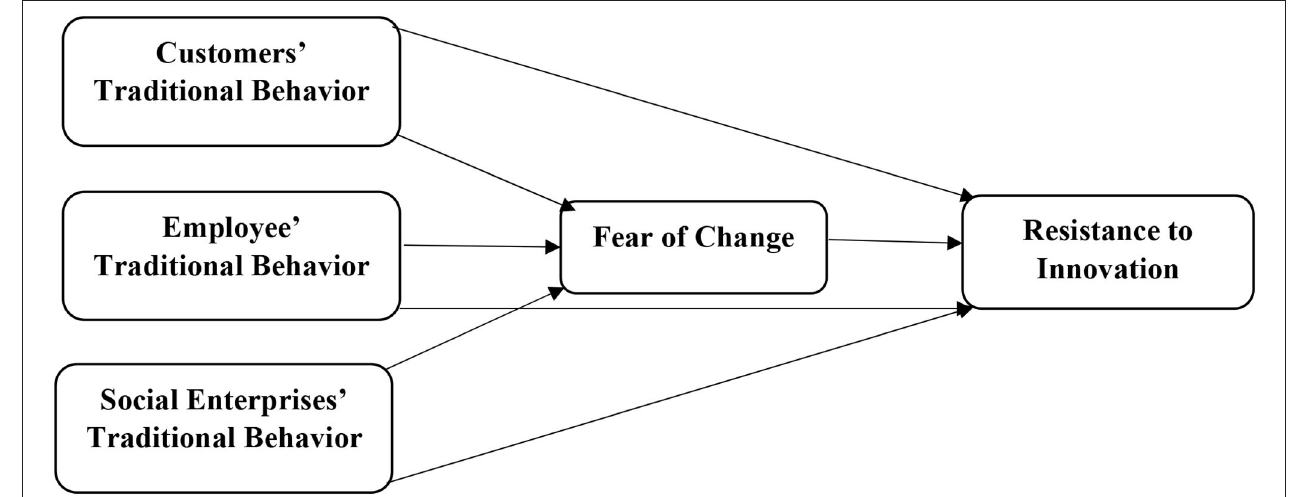
FIGURE 1 | Theoretical